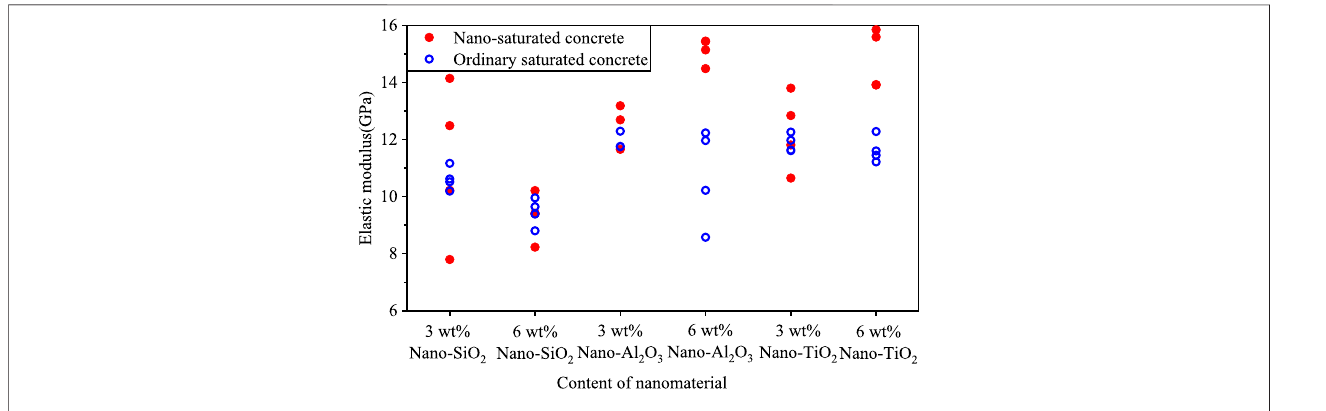
FIGURE 9 | Comparison of elastic modulus of various types of